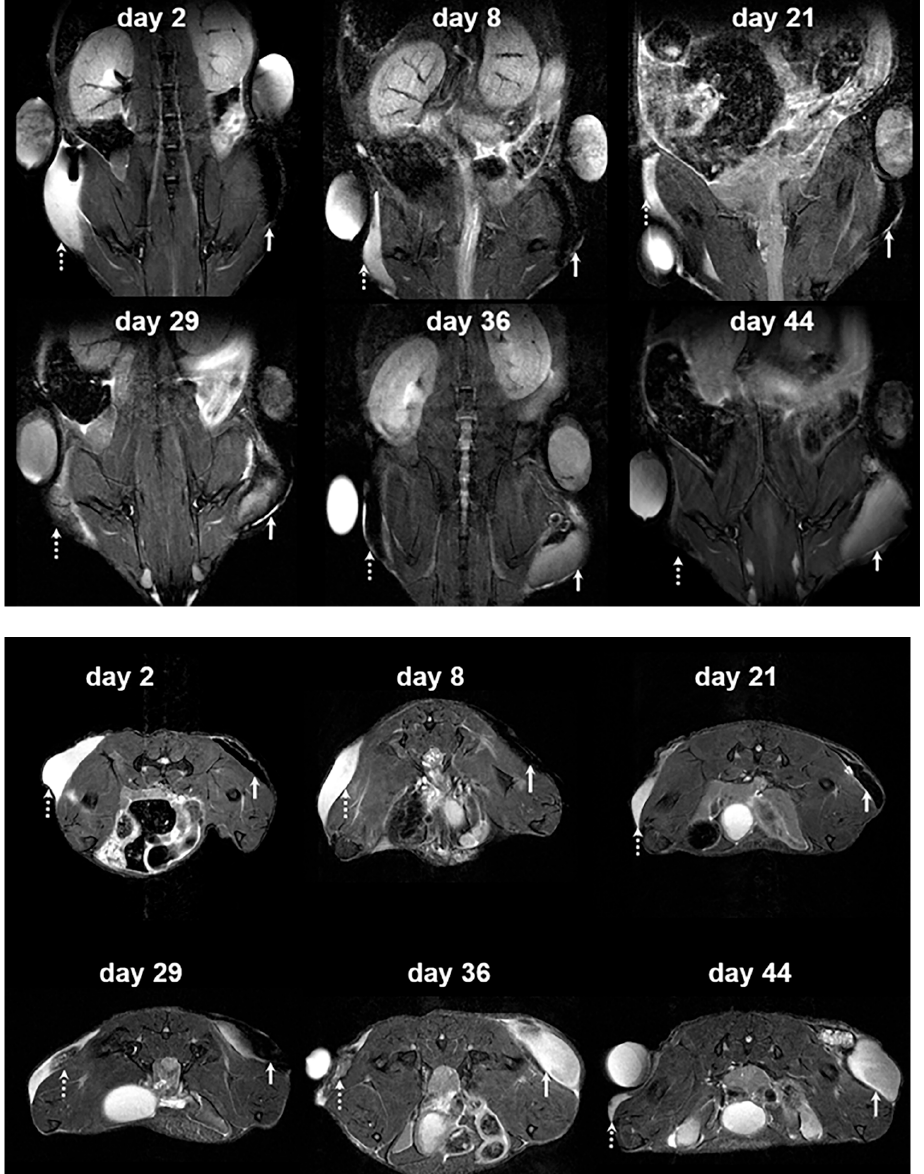
Figure 3. In vivo MR image of hydrogel and hydrogel-embedded MIN6 cells after subcutaneous transplantation. 5 × 10 6 CSPIO-labeled MIN6 cells embedded in mPEG-poly(Ala) hydrogels were subcutaneously transplanted into the right flank of a nude mouse. The hydrogel without MIN6 cells was transplanted into the left flank as a negative control. The recipient was scanned by a 7.0 T MRI system with coronal (upper panel) and transverse (lower panel) sections. The graft of CSPIO-labeled MIN6 cells was indicated by solid arrows and the hydrogel without MIN6 cells was indicated by dashed arrows.